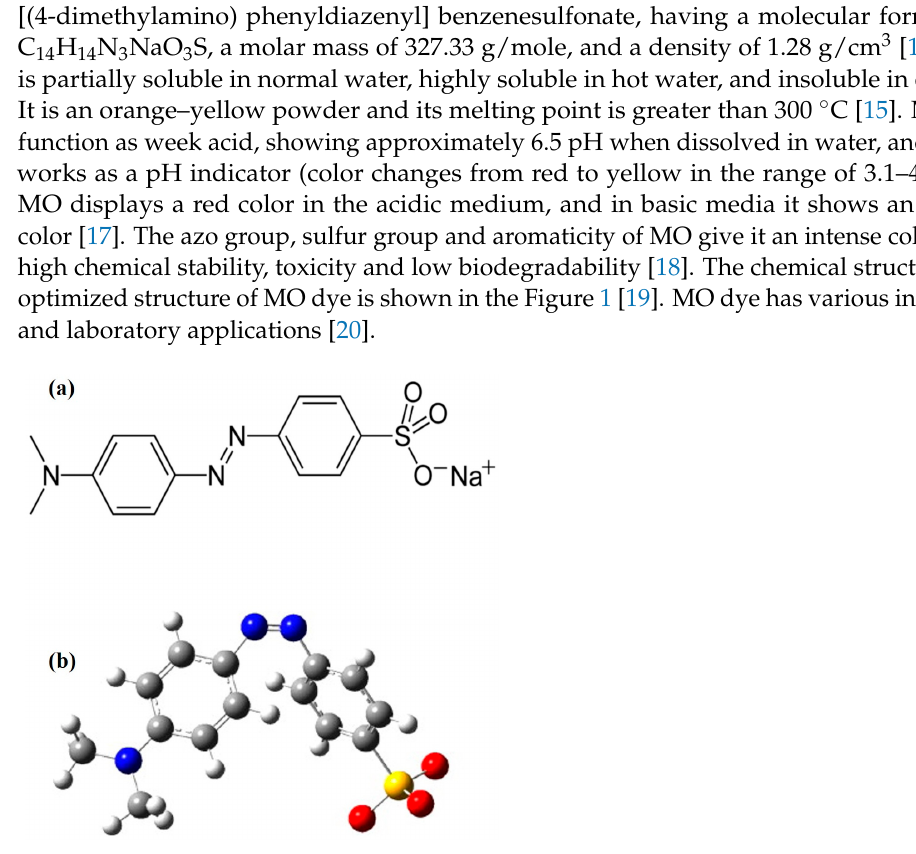
Figure 1. (a) Chemical structure of Methyl orange; ( b ) the optimized MO molecular structure created using Gaussian 03 software package on the basis of the HF/6-31G method. Reprinted/adapted with permission from [19], 2023, Elsevier (License Number 5507170462000).